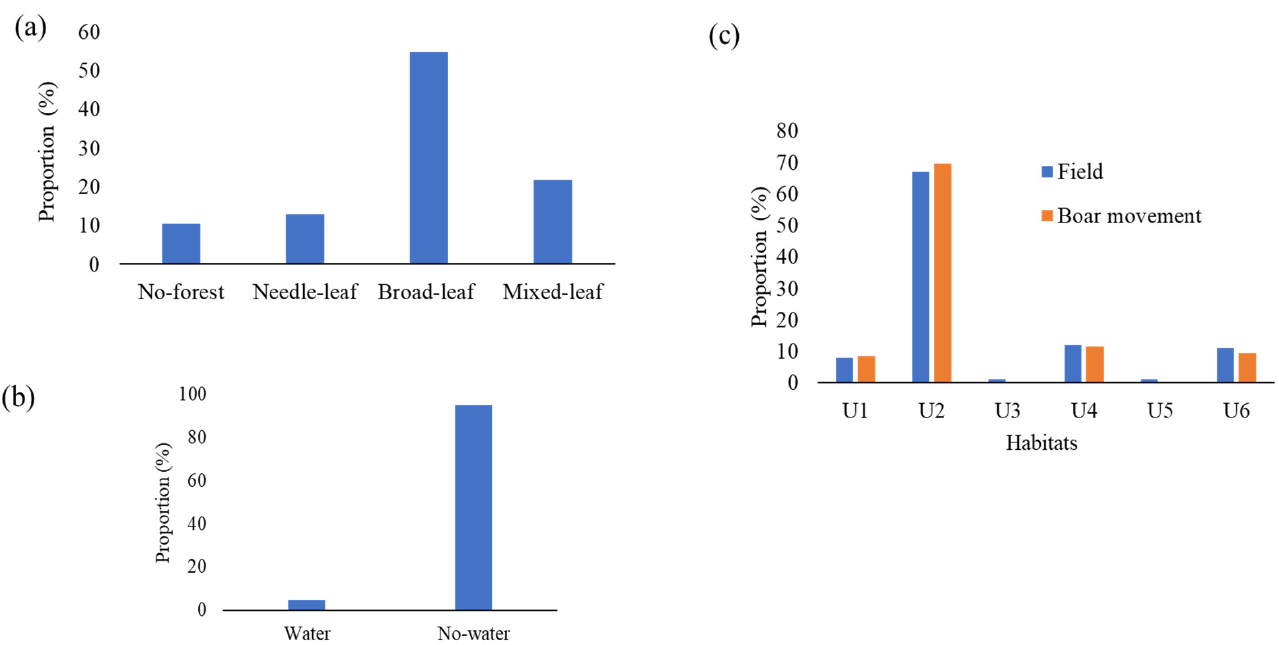
Figure A1. Proportion of landcovers in the Bukhansan National Park, Korea, with ( a ) leaf types, ( b ) water, and ( c ) proportion of different habitats according to field and movement data.